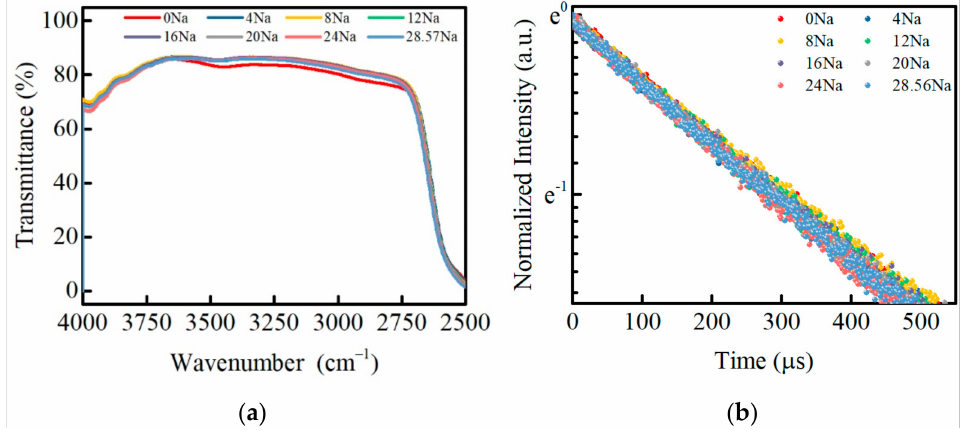
Figure 7. ( a ) Infrared transmission spectra; ( b ) fluorescence decay curve of Nd 3+ ion at 1053 nm in PKNi glasses with different Na/(Na+K) ratios.